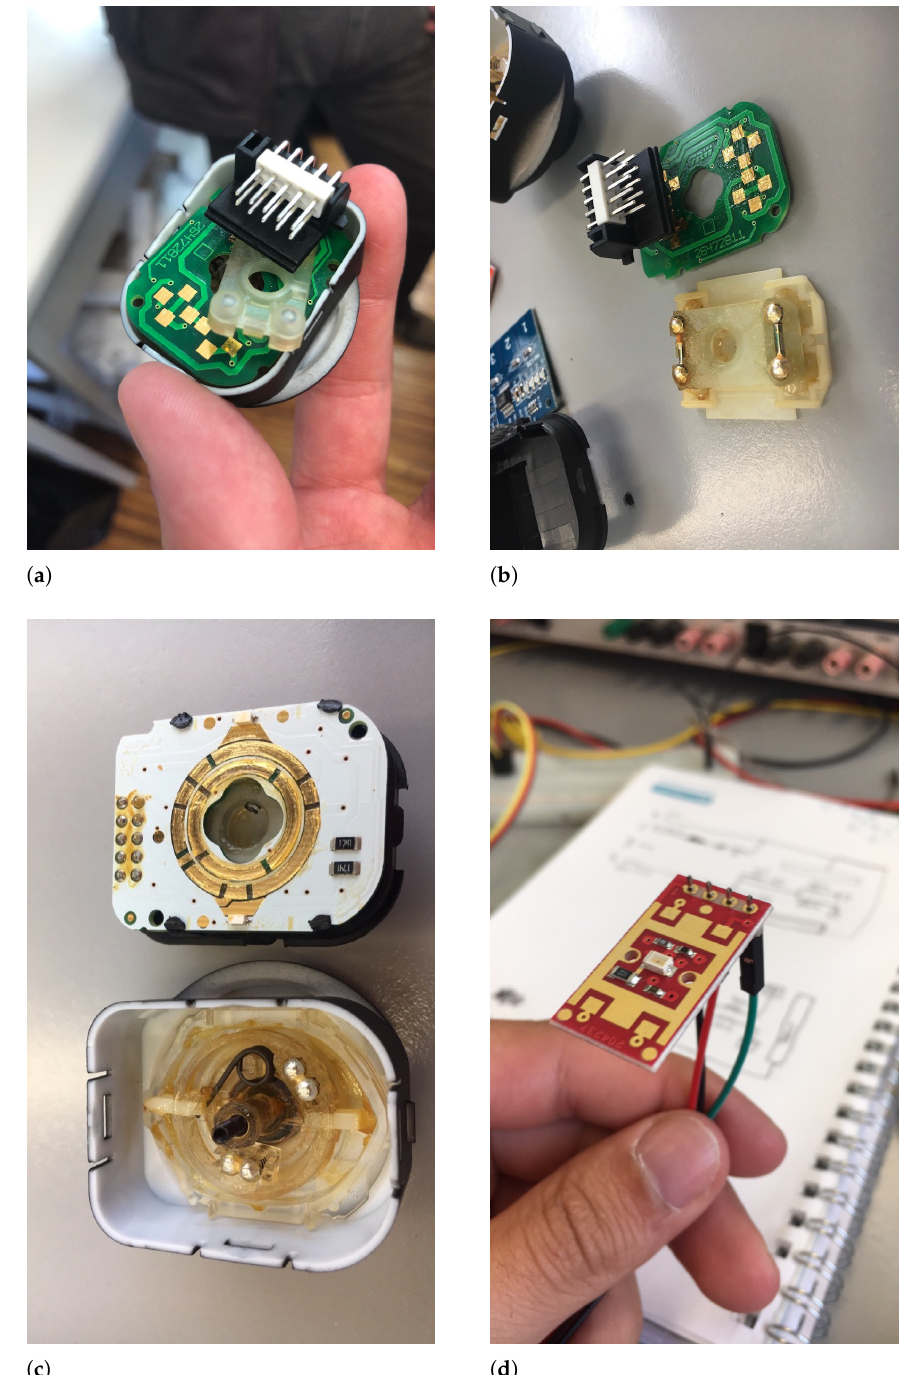
Figure 19. From ( a – d ) the figure illustrates some of the components of joystick rear-view mirrors and buttons used to open/close door windows. ( a – c ) depicts electronic parts of the joystick components and ( d ) illustrates the PCB that interacts with the contacts that are closed/opened by the button. The plastic polymer surface was designed to allow the user to accurately feel where the hand should be placed in order to activate the controls (see Figure 20a), without the need